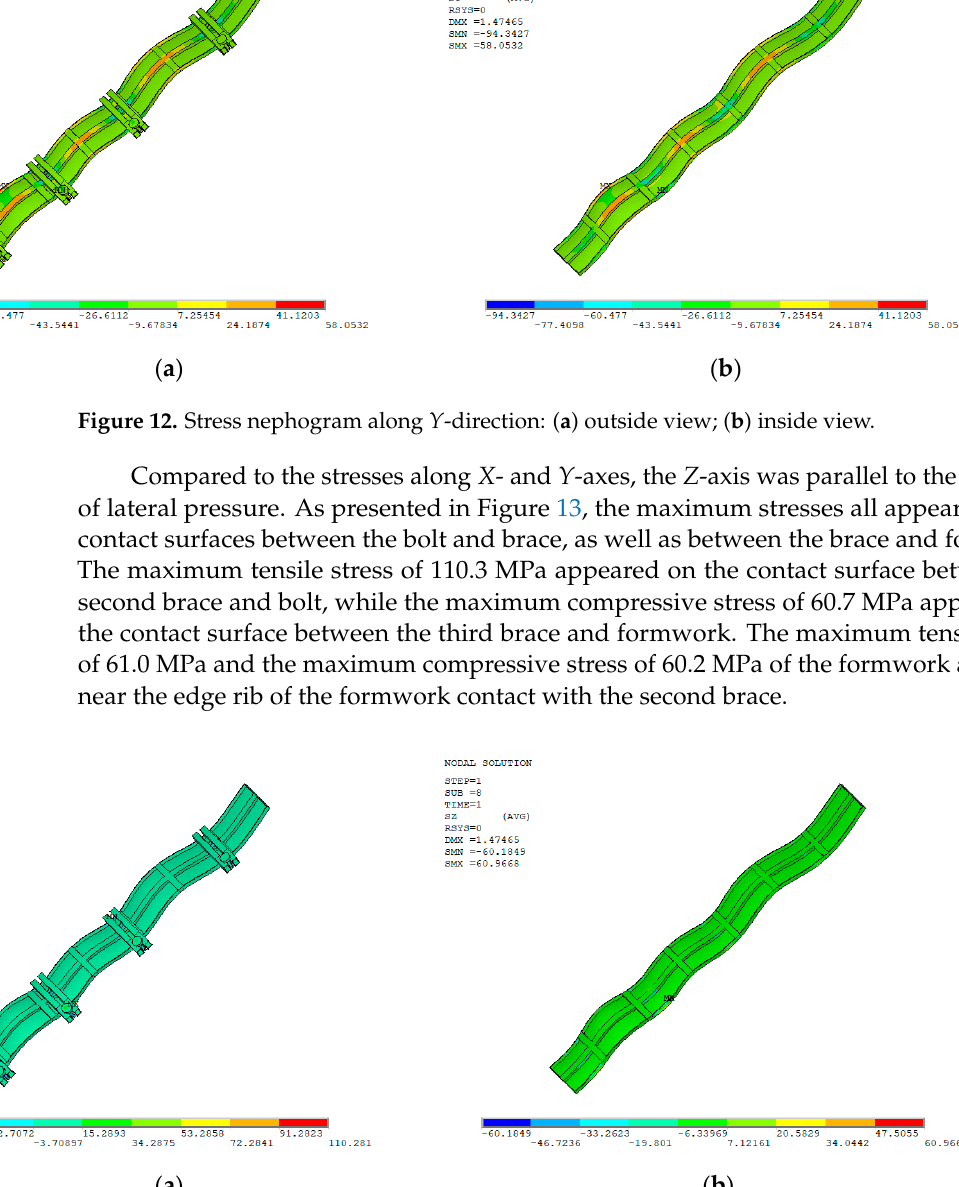
the cantilever ends of the formwork. This meets the requirements of China code JGJ386 Figure 13. Stress nephogram along Z -direction: ( a ) outside view; ( b ) inside view.